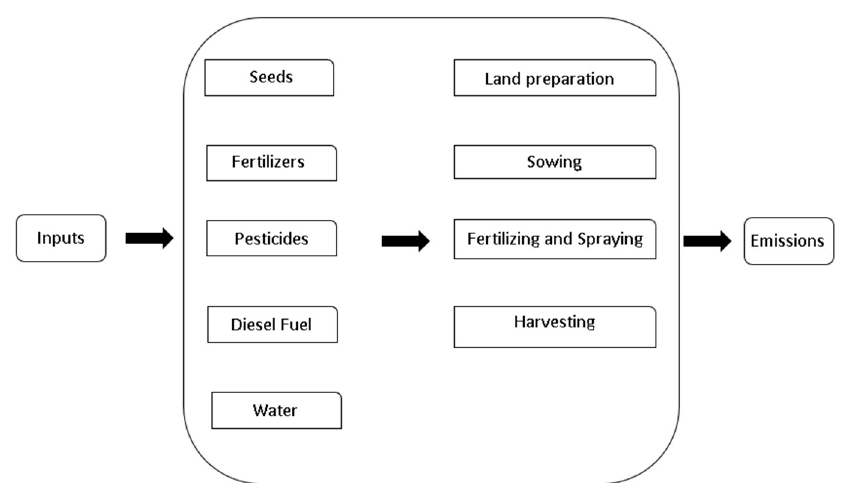
Figure 4. System boundaries in the LCA of selenium potatoes.